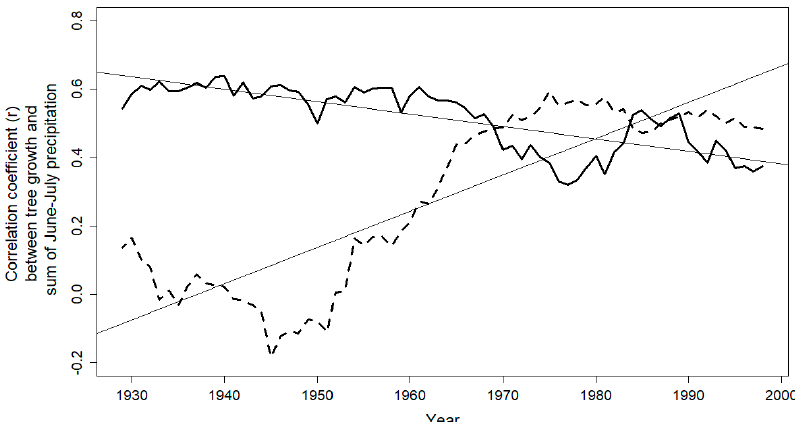
Figure 5. Changes in the influence of the sum of June–July precipitation on tree-ring widths in sequential 30-year time intervals. The solid line represents correlations of tree-ring widths from the Hungarian site with precipitation data. The dashed line shows the correspondence of radial increment development in Polish samples with rainfall. At the Hungarian site, the significant correlation of June–July precipitation to tree-ring growth (~ r = 0.6, p<0.05) decreased by the end of our study period, however, in Poland, despite the decreasing